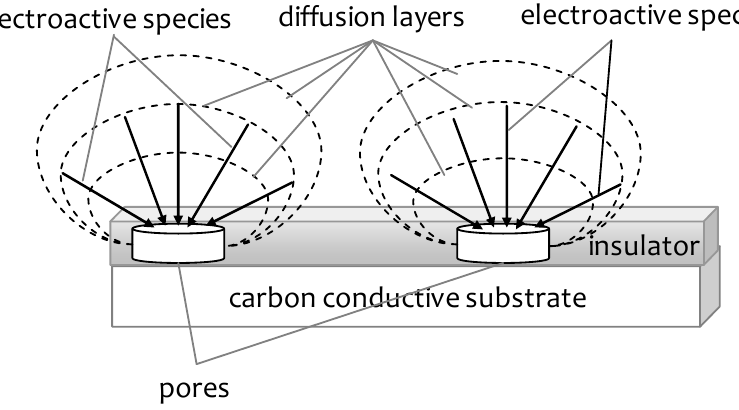
Figure 1. Schematic of the microelectrode response.